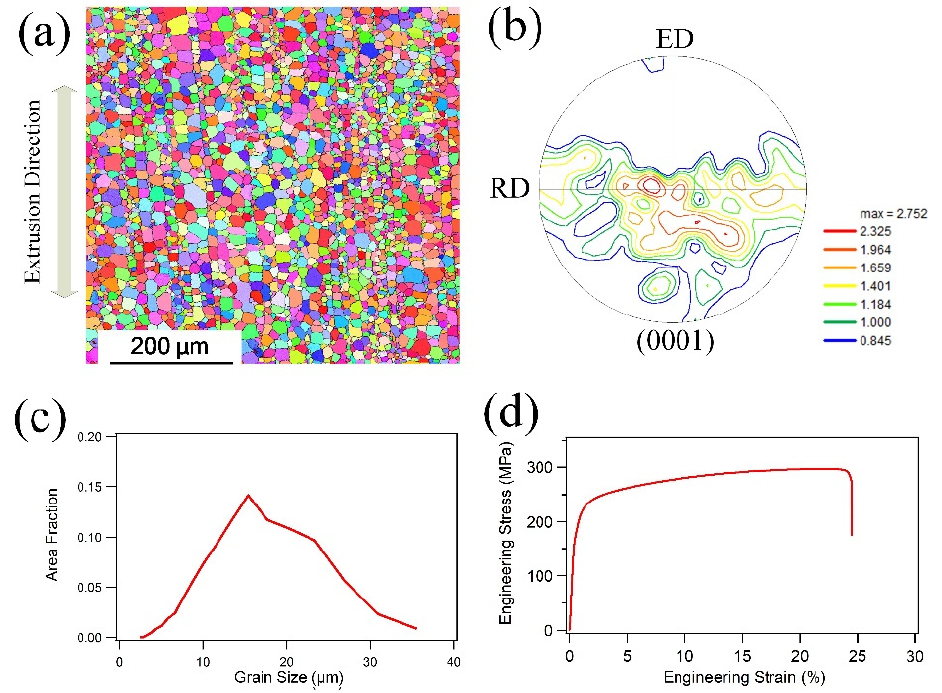
Figure 1. ( a ) Initial microstructure, ( b ) (0001) pole figure ( c ) grain size distribution and ( d ) stress-strain curve of this alloy